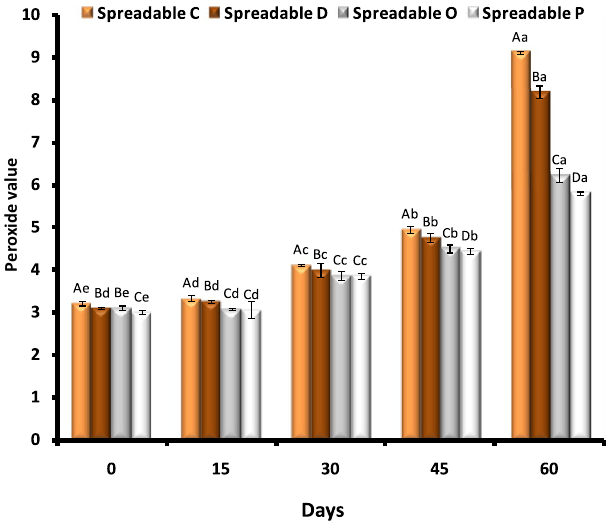
Figure 4. Oxidative stability of the oleogel samples (O, P, D, and C) as evaluated by peroxide value (PV) measurement. Bars represent the standard error of the mean values. Columns with similar letters are not statistically different according to DMRT (p ≤ 0.05). Capital letters refer to the same time, while small letters refer to the same sample at different times.